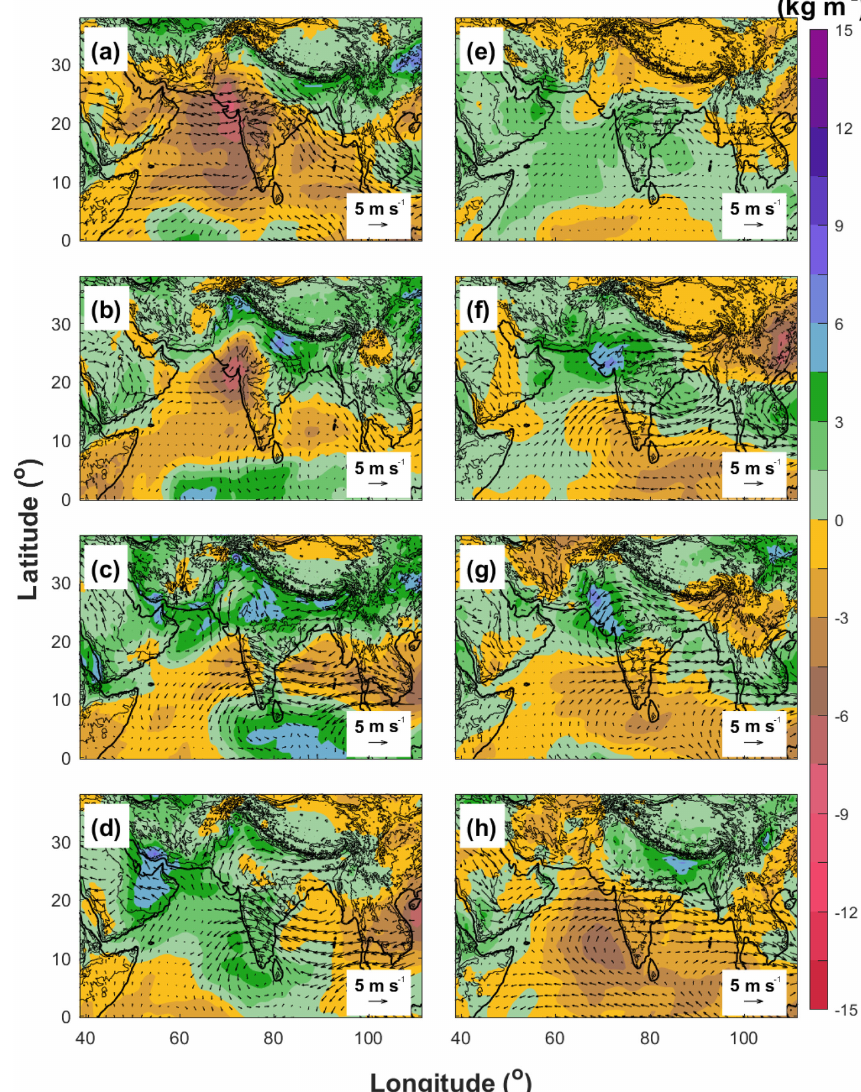
Figure 14. Phase composites of 850hPa wind and precipitable water anomalies obtained from ERA-Interim ( a–h : Phase 1 to